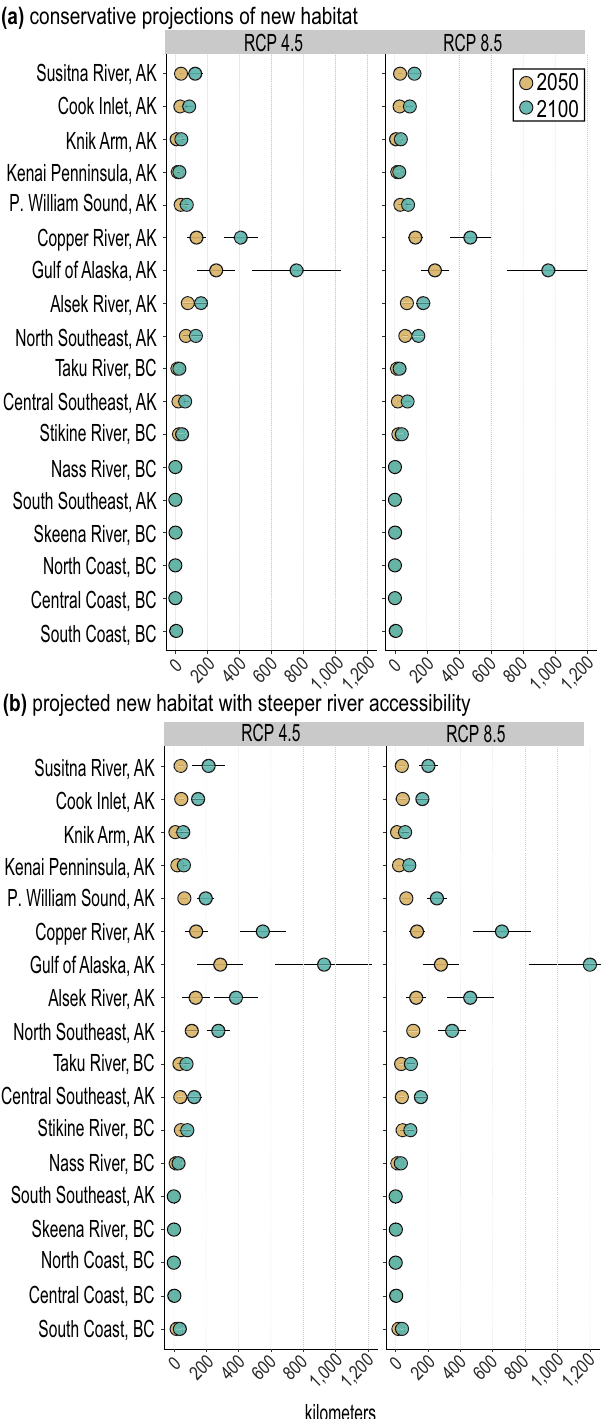
Fig. 3 Projected kms suitable for salmon spawning and juvenile rearing habitat by 2050 and 2100 for each of the 18 sub-regions. Habitat kms for the 18 sub-regions were computed from a glacier projection model for the years 2050 (yellow) and 2100 (green), based on 10-year averages centred around these years. The 18 sub-regions are listed from higher to lower latitude. a Projected kms of spawning and juvenile rearing habitat (0 – 2% gradient) from salmon-accessible (<10% gradient) streams larger than fi rst order. b Projected kms of spawning and juvenile rearing suitable habitat (0 – 4% gradient) from salmon-accessible streams with steeper accessibility (<15% gradient). Uncertainty corresponds to ensemble-mean ± one standard deviation and originate from: GCM projections (for RCP4.5; N = 5), ice thickness estimates, and stream segment length (see Methods section “ Uncertainty estimates ” ). Projected future salmon-accessible stream kms (±one standard deviation) are presented in Source Data